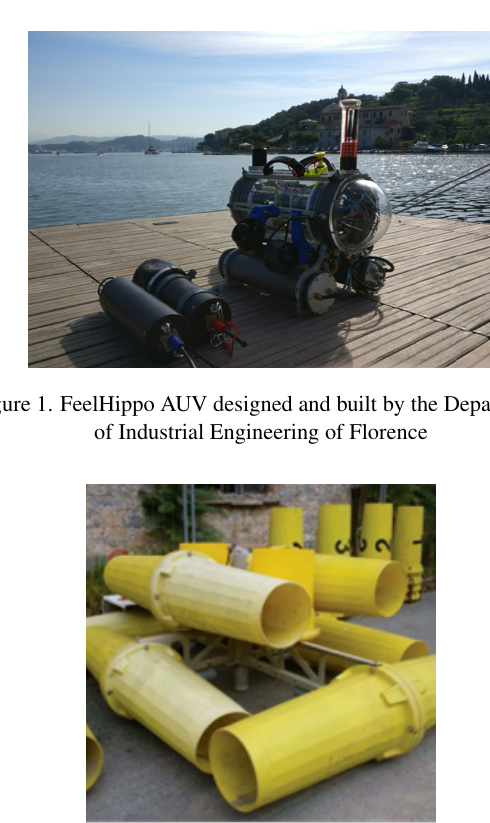
Figure 2. Empty plastic cylinders representing a submerged